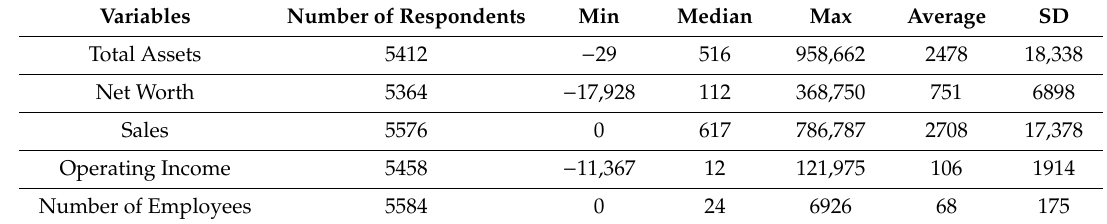
Table 1. Descriptive statistics about respondents for the latest business year. 1